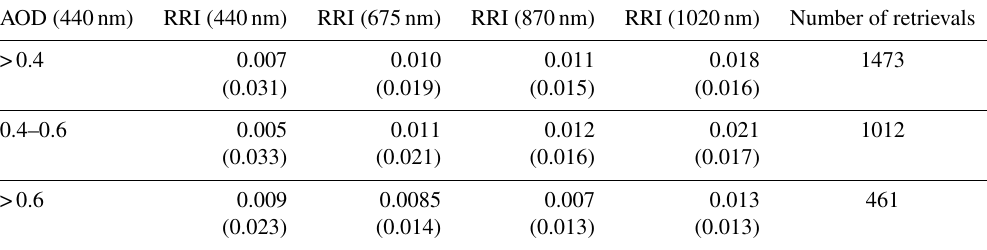
Table 2. Statistics, average values and standard deviations (in parentheses) of the difference in the real part of refractive index (RRI) retrievals of V2 and V3 for the Mezaira site. The difference is defined as V3 −